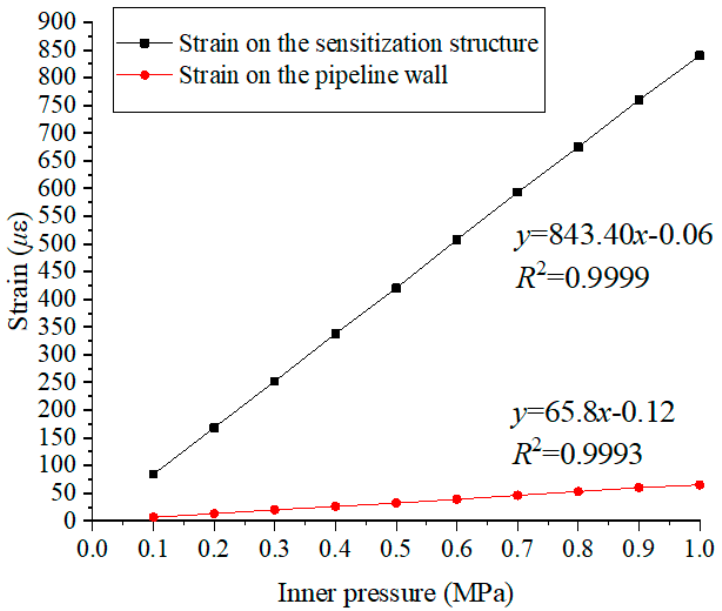
Figure 12. Strain distribution under different pressure values.